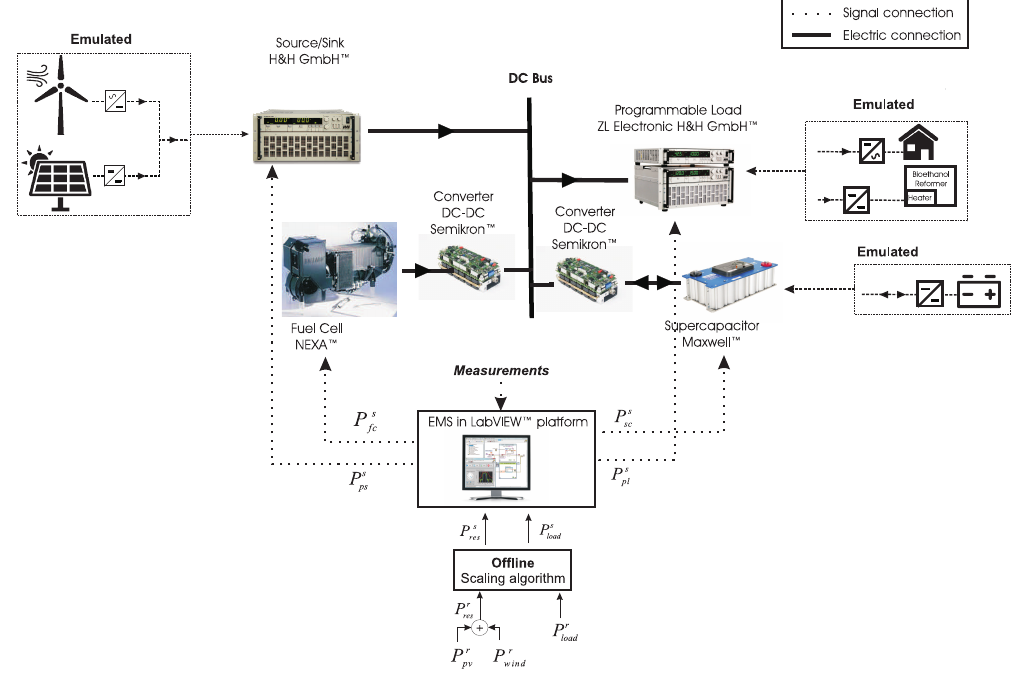
Figure 8. Laboratory system control scheme and experiment configuration. The dotted boxes show the elements of the real system to be emulated, and the arrow indicates the laboratory equipment used to emulate this